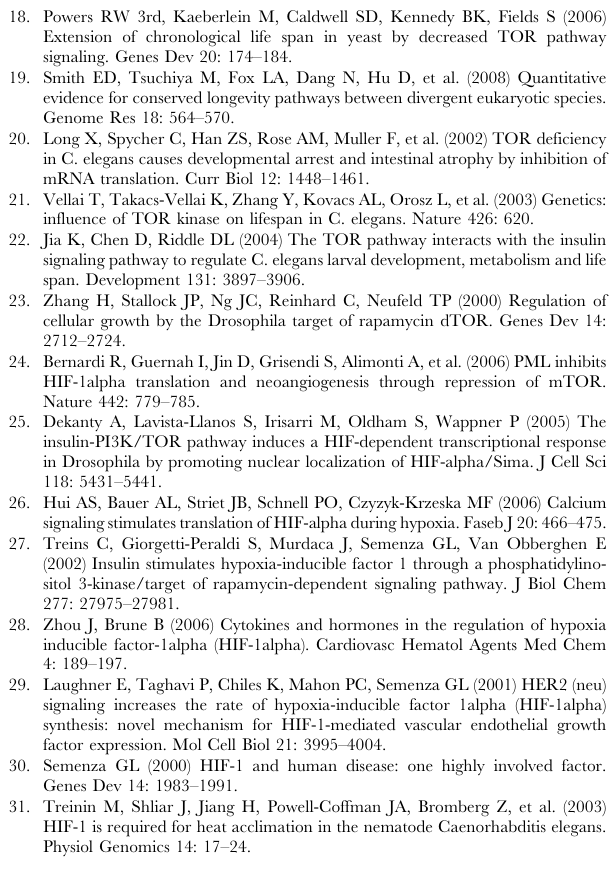
Figure S8 C14B9.2 mRNA levels are regulated by DR and HIF-1. DR reduces C14B9.2 transcription in N2, hif-1 and egl-9 ( p , 0.05, t - test). Overexpression of HIF-1 due to the egl-9(sa307) mutation results in increased C14B9.2 transcription under both AL and DR conditions ( p , 0.01, t - test). qRT-PCR experiments were performed twice with consistent results using two indepen- dent RNA preparations. Table S1 HIF-1 functions in the TOR-S6K pathway to modulate C. elegans lifespan.